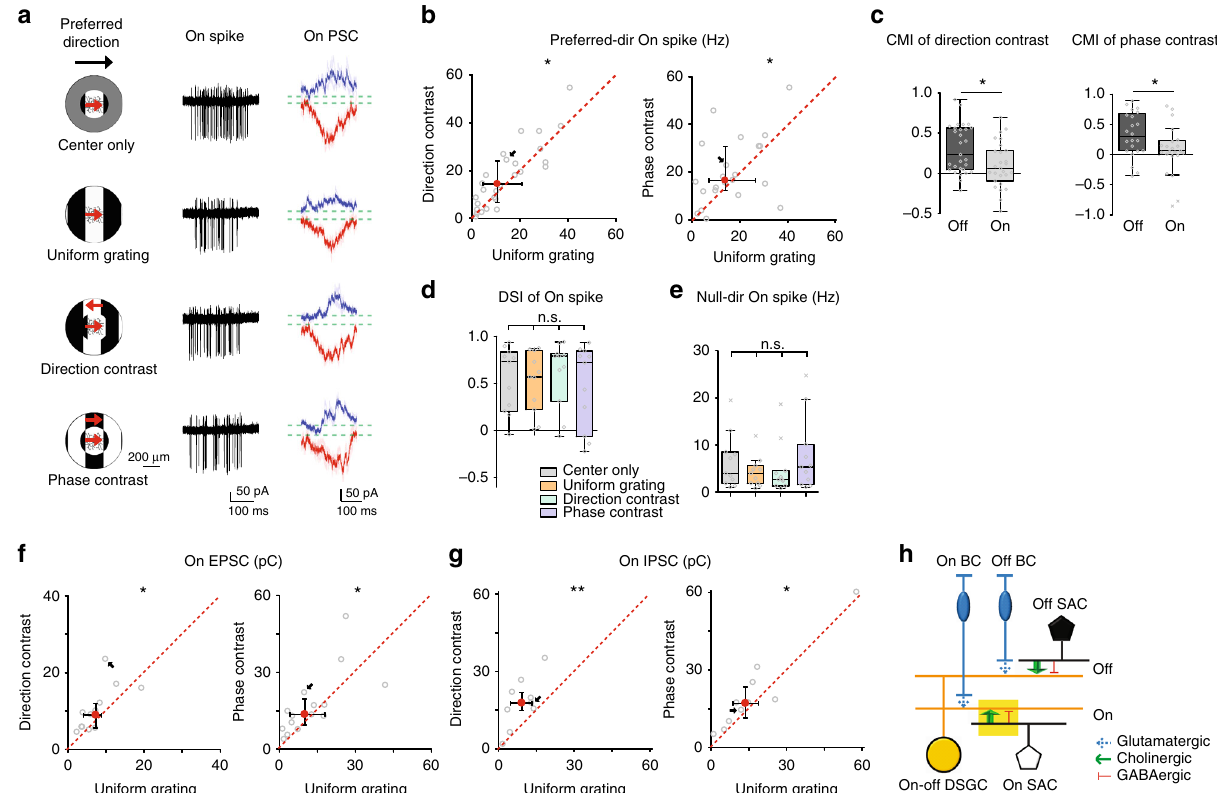
Fig. 4 Contextually sensitive cholinergic excitation underlies the weak contextual modulation of pDSGC On response. a Left: Visual stimuli with different motion contexts. Middle: Example On spike traces of a pDSGC from a control mouse. Right: Whole-cell recording traces of On IPSCs (blue) and On EPSCs (red) from a pDSGC in a control mouse. b Scatter plots compare pDSGC preferred-direction On spike fi ring rate during uniform grating and compound gratings. Direction-contrast vs uniform grating: n = 27 cells from 10 mice, * p = 0.036; Phase-contrast vs uniform grating: n = 22 cells